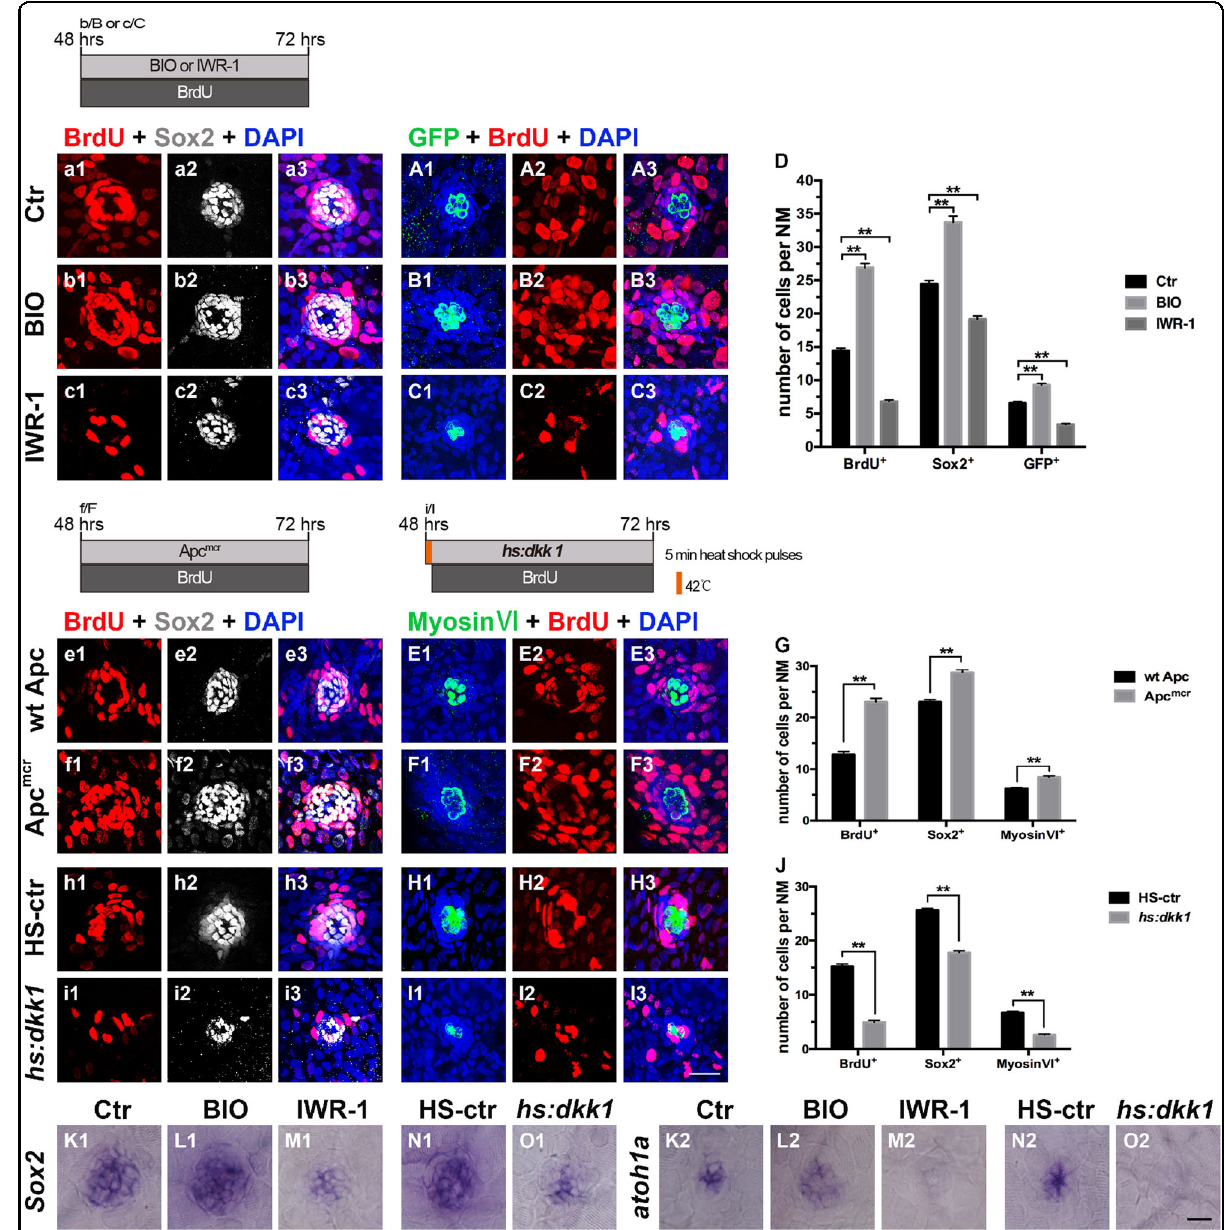
Fig. 1 Effects of Wnt signaling on cell proliferation in the developing neuromast. a1 – C3 : Proliferative cells labeled with BrdU (red), SCs labeled with Sox2 (white), and HCs labeled with GFP (green). a1 – A3 : Control neuromasts; b1 – B 3: After addition of BIO; c1 – C3 : After addition of IWR-1. d : Quanti fi cation of proliferative cells (BrdU + ), SCs (Sox2 + ), and HCs (GFP + ) shown in a1 – C3 . e1 – F3 and h1 – I3 : Proliferative cells labeled with BrdU (red), SCs labeled with Sox2 (white), and HCs labeled with myosin VI (green). e1 – E3 : wt Apc larvae; f1 – F3 : Apc mcr mutants showing elevated Wnt/ β -catenin activity; h1 – H3 : Heat shock-negative control larvae (HS-ctr); i1 – I3 : Wnt repression by heat shock induction of the hs:dkk1 transgene ( hs:dkk1 ). g , j : Quanti fi cation of the proliferative cells (BrdU + ), SCs (Sox2 + ), and HCs (Myosin VI + ) shown in e1 – F 3 ( g ) and h1 – I3 ( j ). n = 5 – 7 fi sh per group. ** Indicates p < 0.001, and error bars indicate the standard error of the mean. K1 – O1 and K2 – O2: WISH analysis of Sox 2 ( K1 – O1 ) and atoh1a ( K2 – O2 ) expression in the neuromasts from different groups. Scale bar in I3 = 20 μ m for a1 – C3 , e1 – F3, and h1 – I3. Scale bar in O2 = 30 μ m for K1 – O1 , K2 –